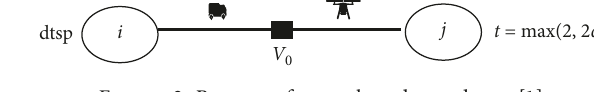
Figure 2: Best case for truck and one-drone [1].